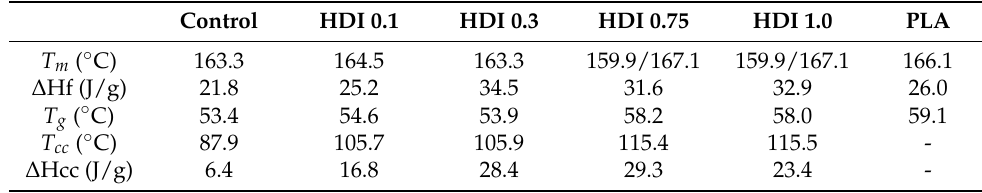
Table 5. DSC data of the PLA/PBSeT blends with various HDI